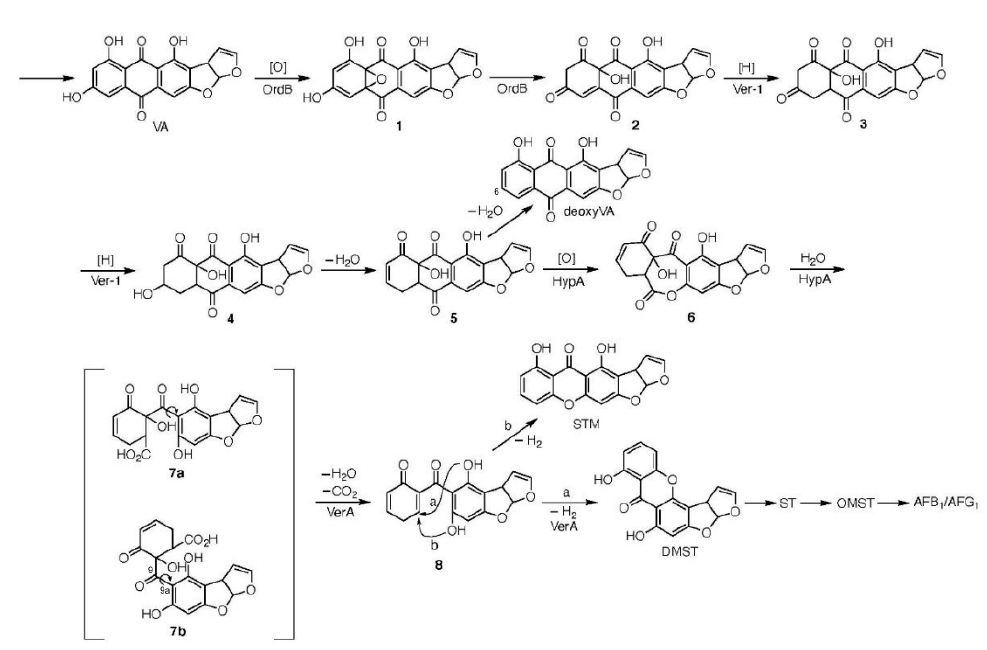
Figure 7. The postulated pathway of the conversion of VA to DMST via the formation of HAMA (intermediate 7 ). ver -1, hypA and ordB are involved in the pathway from VA to HAMA, because each gene disruptant converted HAMA to AFB 1 and AFG 1 . HAMA is shown as intermediate 7a or 7b based on the molecular mass (374); 7a and 7b are different conformers of HAMA. The LC-MS analysis showed that HAMA is composed of two types of conformers, and each conformer corresponds to either an STM-like structure and a DMST-like structure. Although either conformer of HAMA is speculated to be non-enzymatically converted to DMST or STM, VerA giostereospecifically converts either conformer to intermediate 8 through dehydration and decarboxylation and then converts the resulting intermediate 8 to DMST through dihydroxylation (pathway a). Intermediate 8 is also non-enzymatically converted to DMST (pathway a) and STM (pathway b) at the ratio of 1:1 in their quantities. The same reaction steps may be involved in the formation of DHDMST from VB except that all intermediates are dihydro-derivatives of the intermediates of the 1-group AFs.